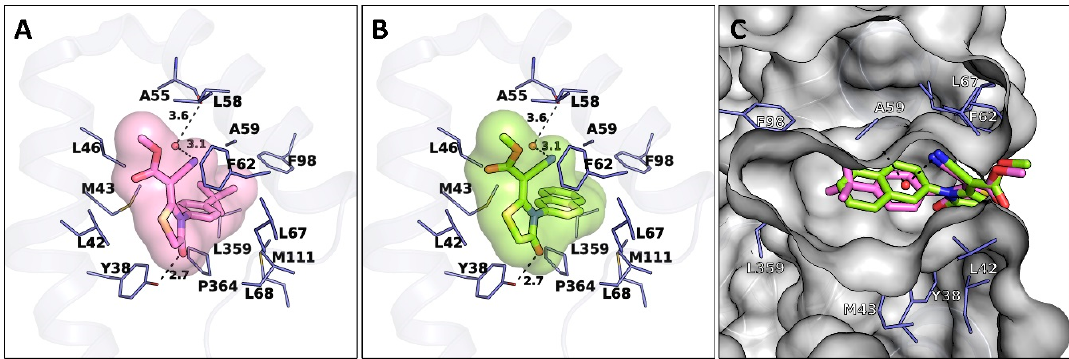
Figure 2. Proposed binding modes of 4-thiazolidinone derivatives 7 ( A ) and 8 ( B ). The X-ray crystal structure of h DHODH with PDB ID of 4LS1 was used in molecular docking. Figure 2 C is an overlay of compounds 7 and 8 .